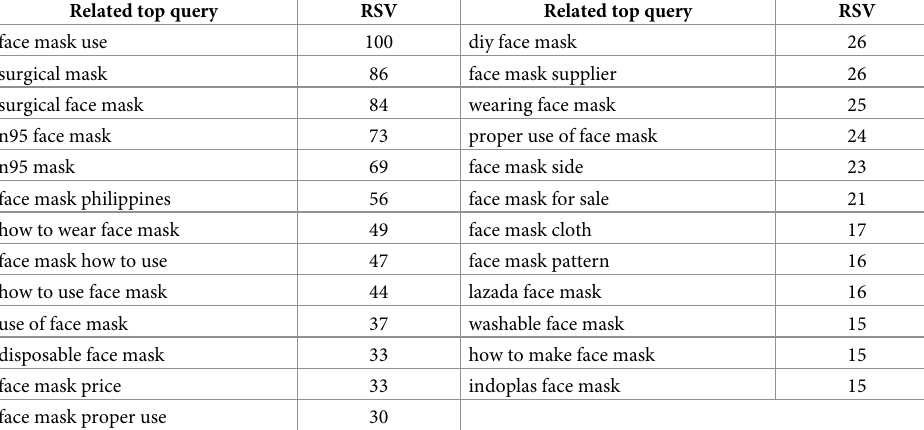
Table 2. Related top queries and search interest value for “face mask” + facemask.